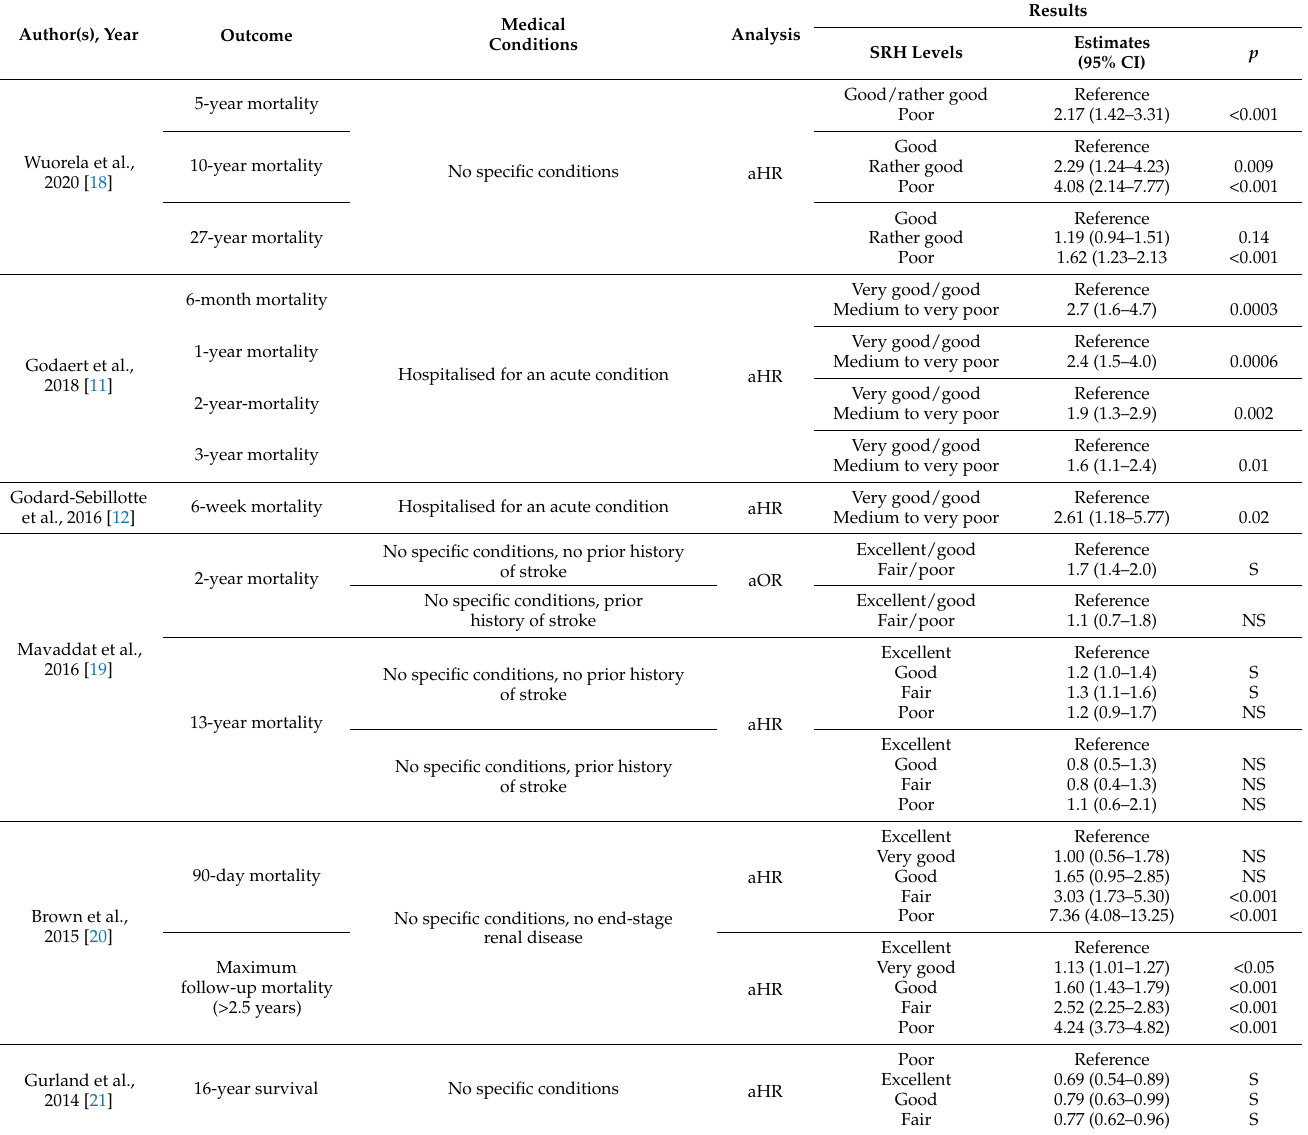
Table 2. Outcome and results of association between SRH and mortality in aged